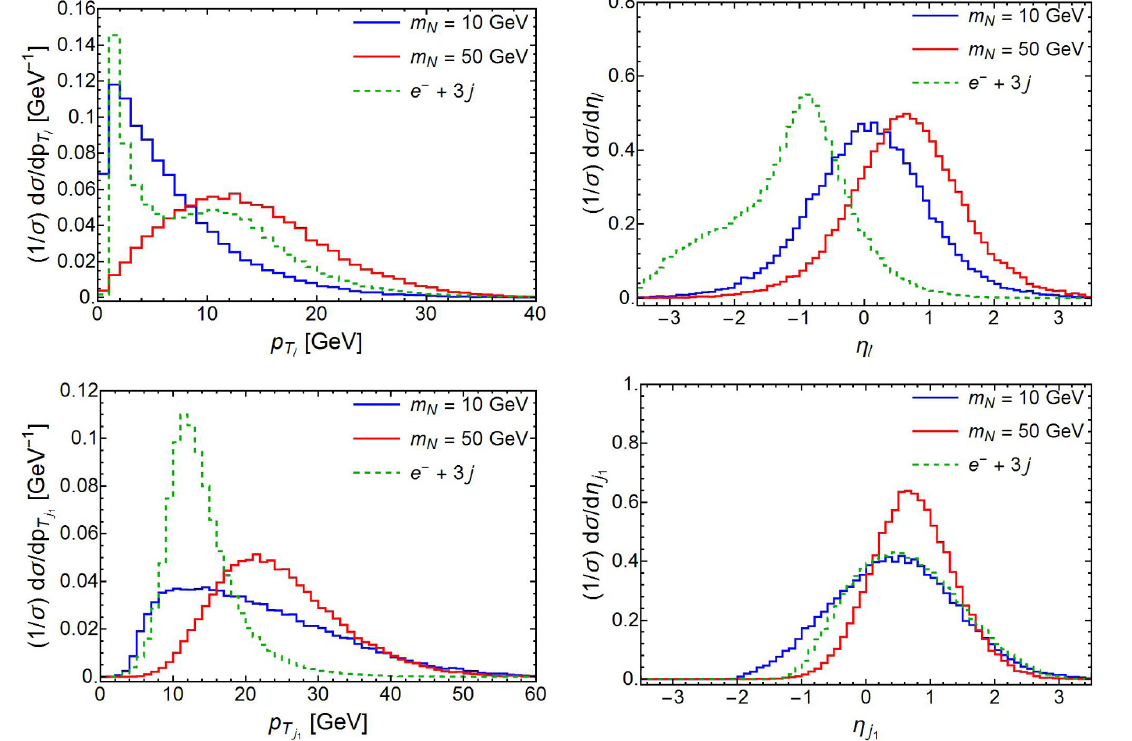
Figure 4 . The transverse momentum (left panels) and pseudo-rapidity (right panels) distributions of the lepton (top panels) and the leading jet (bottom panels) of the signal and the e − + 3 j background in the e − p → e + jjj channel before applying the cuts of eqs. (4.1) and